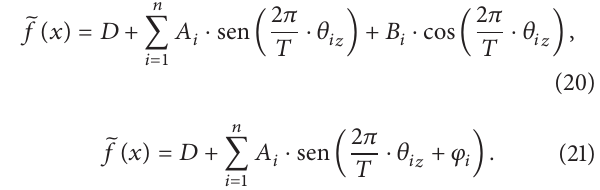
Table 1: Optimization with